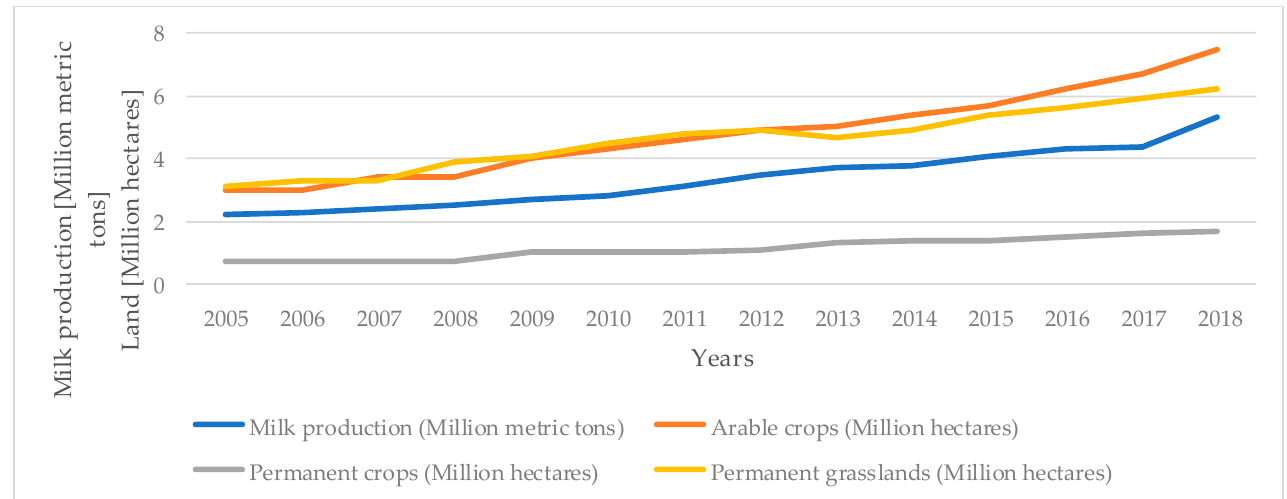
Figure 1. Development of organic cow’s milk production and organic lands in the European Union (EU) Source: own study based on data from EUROSTAT.